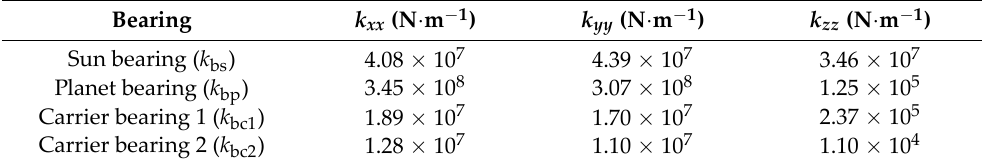
Table 2. Bearing